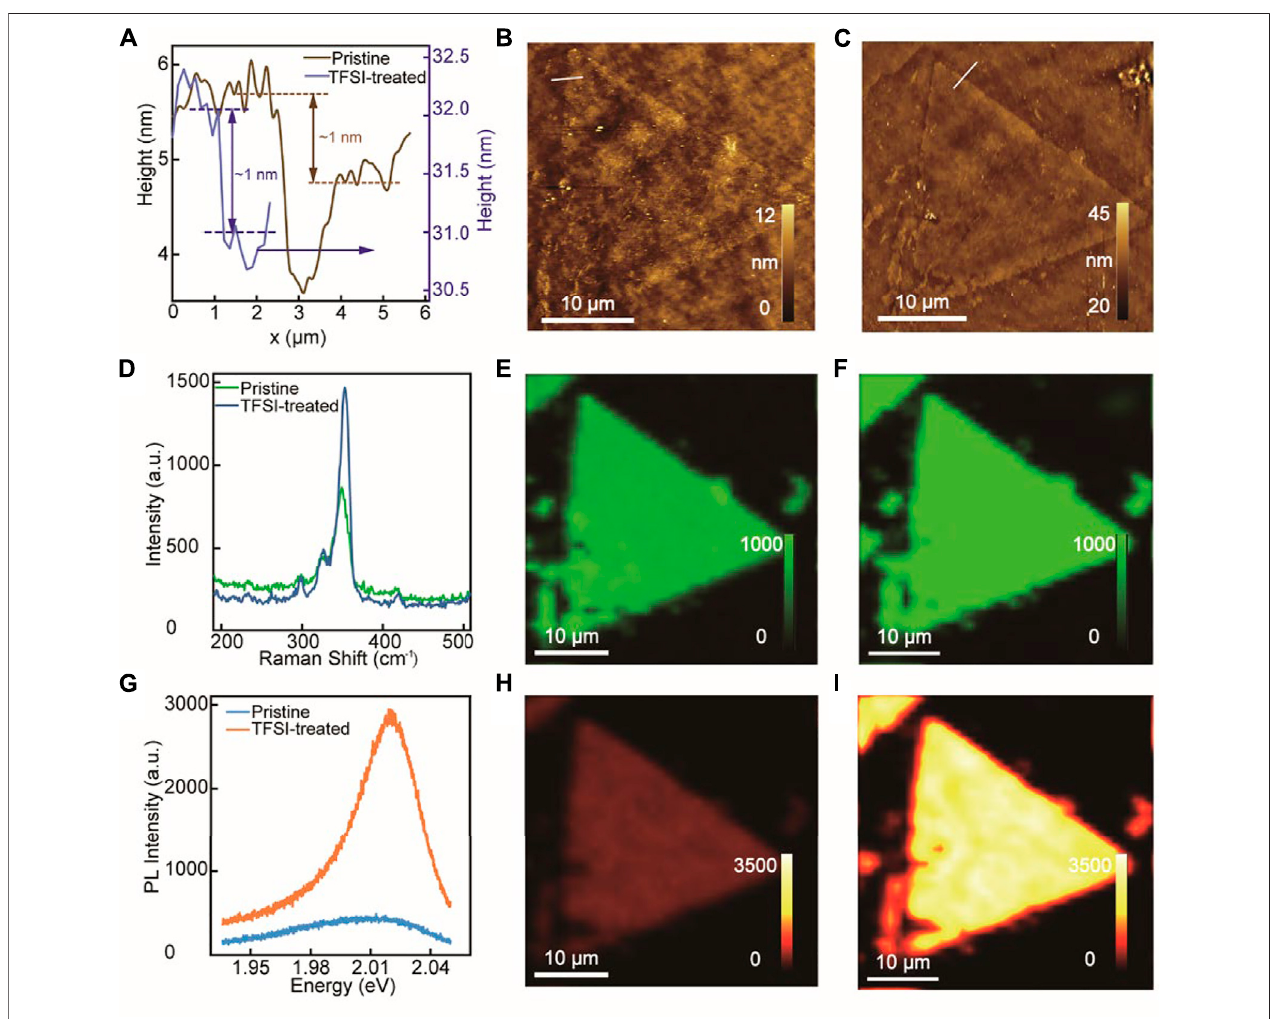
FIGURE2| CharacterizationsofthemonolayerWS 2 fl akeafterincubationinTFSIsolutionof0.1 mg/ml. (A) Topographiesofthepristine(brownline)andincubated (blue line) WS 2 fl ake. (B, C) AFM images of the pristine (B) and incubated (C) WS 2 fl ake. The topographies are drawn along the white lines shown in (B) and (C) . (D) RamanspectraofthemonolayerWS 2 before(greenline)andafter(blueline)TFSIincubation. (E,F) 2DRamanintensitymappingsoftheWS 2 fl akebefore (E) andafter (F) the TFSI incubation. The Raman mappings are monitored at 352 cm − 1 . (G) PL spectra of the monolayer WS 2 before (blue) and after (orange) the TFSI incubation. (H , I) 2D PL intensity mappings of the WS 2 fl ake before (H) and after (I) the TFSI incubation. The PL mappings are recorded at 615 nm.